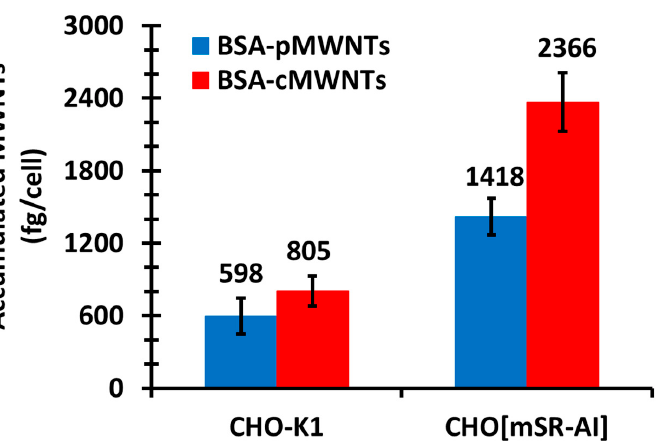
Figure 6. Accumulation of BSA-MWNTs by wild-type Chinese hamster ovary (WT CHO)-K1 control cells and Chinese hamster ovary (CHO) cells that overexpress SR-A1 receptors (CHO[mSR-AI] cells) at 37 °C. Equivalent numbers of each cell line were seeded in 6-well plates and incubated at 37 °C under standard cell culture conditions for 24 h prior to the experiment. The cells were then incubated at 37 °C for 24 h in medium that contained BSA-pMWNTs (blue bars) or BSA-cMWNTs (red bars) each at 100 µg/mL. After incubation, MWNTs were extracted from the cells and quantified by the SDS-PAGE method. The numbers above the data points are the mean femtograms of MWNTs/cell, and each data point is the mean of ≥ 3 experiments ± SD.